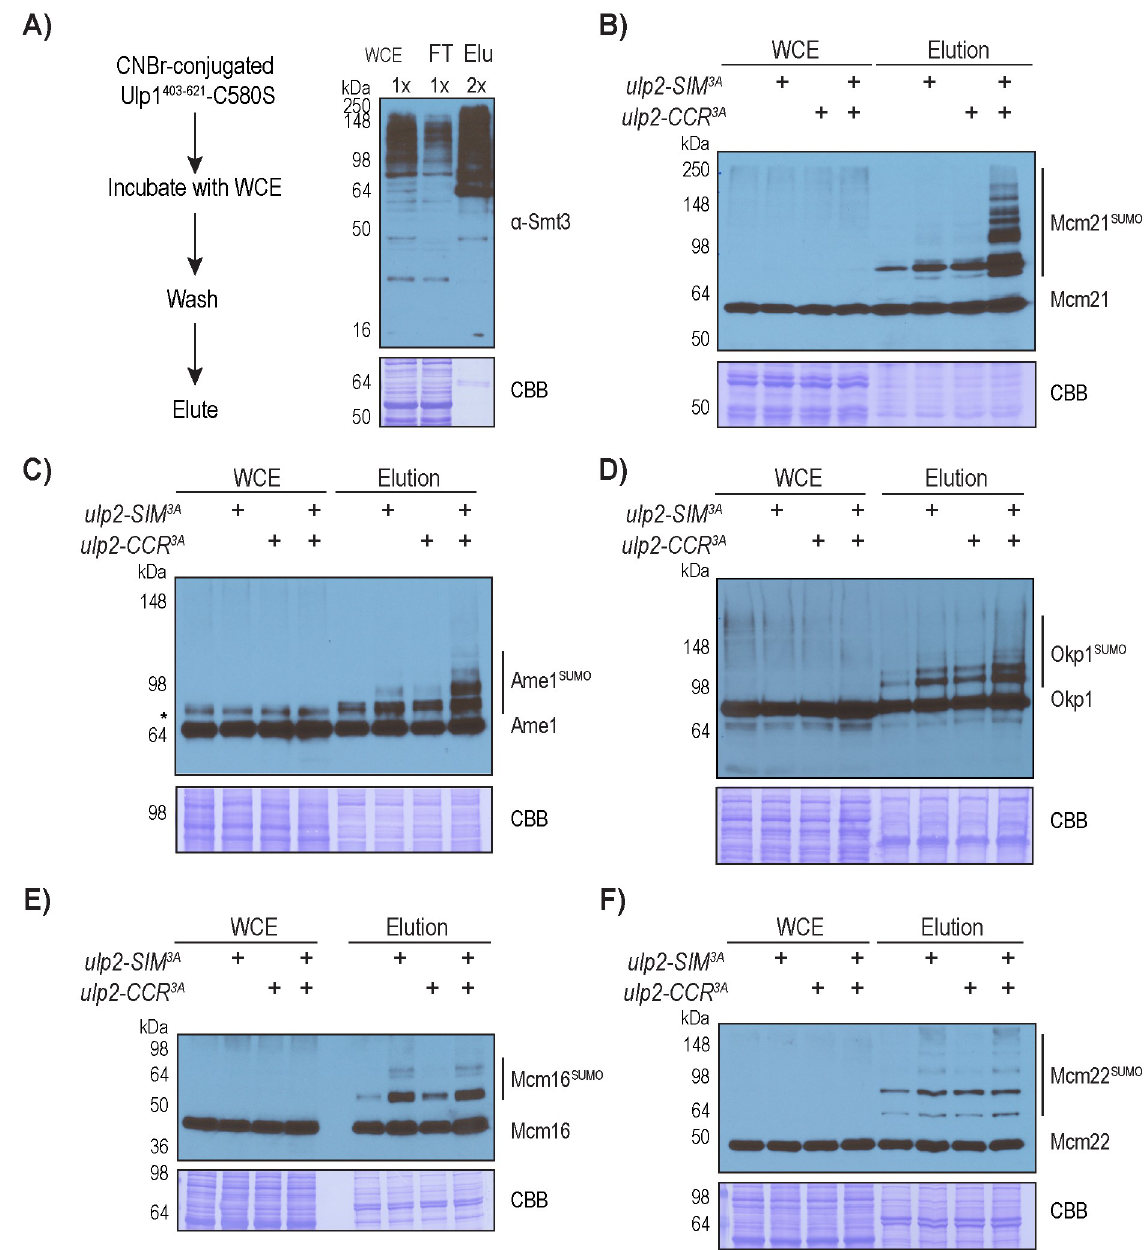
Fig 2. Desumoylation of CCAN is partially redundantly controlled by Ulp2’s SIM and CCR. A) Anti-Smt3 Western blot to observe total sumoylated proteins via the Ulp1-C580S pull-down approach. Relative loading amounts are indicated at the top of each sample lane. 2B-2F) Protein A tagged Mcm21, Ame1, Okp1, Mcm16 and Mcm22 were detected using an anti-Protein A antibody and Western blot analysis. Approximately 150-fold more loading was used for the eluted samples compared to the input samples. Sumoylated species of these CCAN subunits were only detected in the purified sample, which appear as higher molecular weight bands compared to the corresponding un- sumoylated CCAN